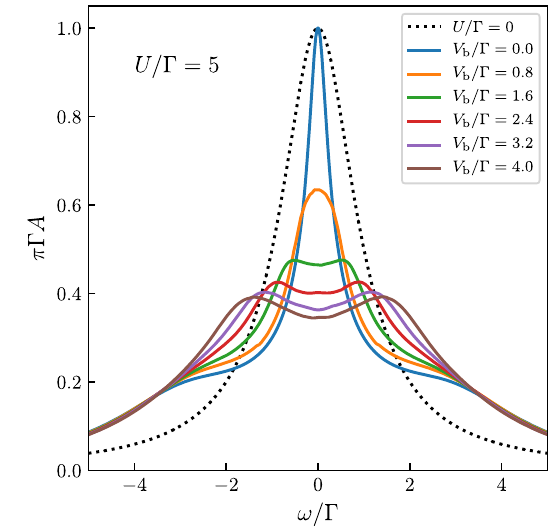
FIG. 13. Out-of-equilibrium spectral functions with interaction = Γ ¼ 0 ) model with a strength U= Γ ¼ 5 , in the symmetric ( ϵ d symmetric voltage bias V . The resulting self-energy series is b resummed in a similar fashion as for the previous results. The noninteracting spectral function is shown as a dotted